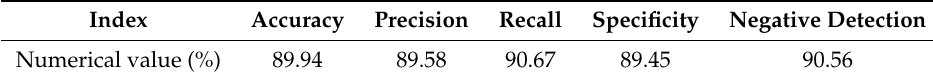
Table 25. Detection evaluation indices.